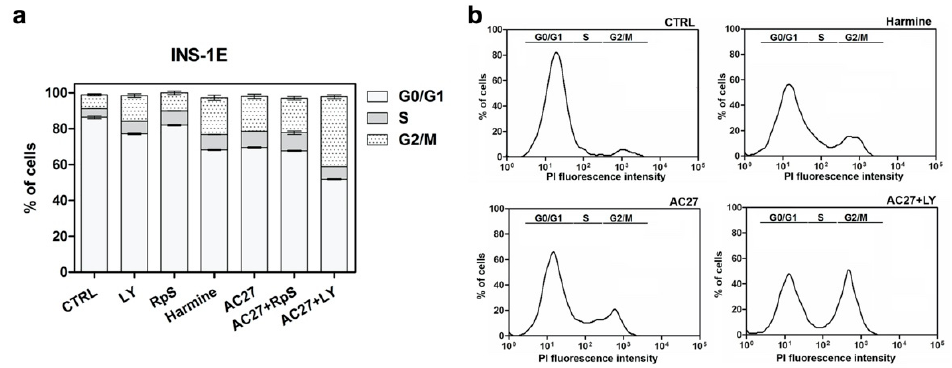
Figure 10. ( a ) Effects of the harmine, AC27 and AC27-TGF β inhibitor combination on the cell cycle. ( b ) Histogram of INS-1E stained with propidium iodide showing DNA content distribution after the 24 h treatment with tested compounds (5 μ M). G0/G1 and G2/M phase histogram peaks are separated by the S-phase distribution.